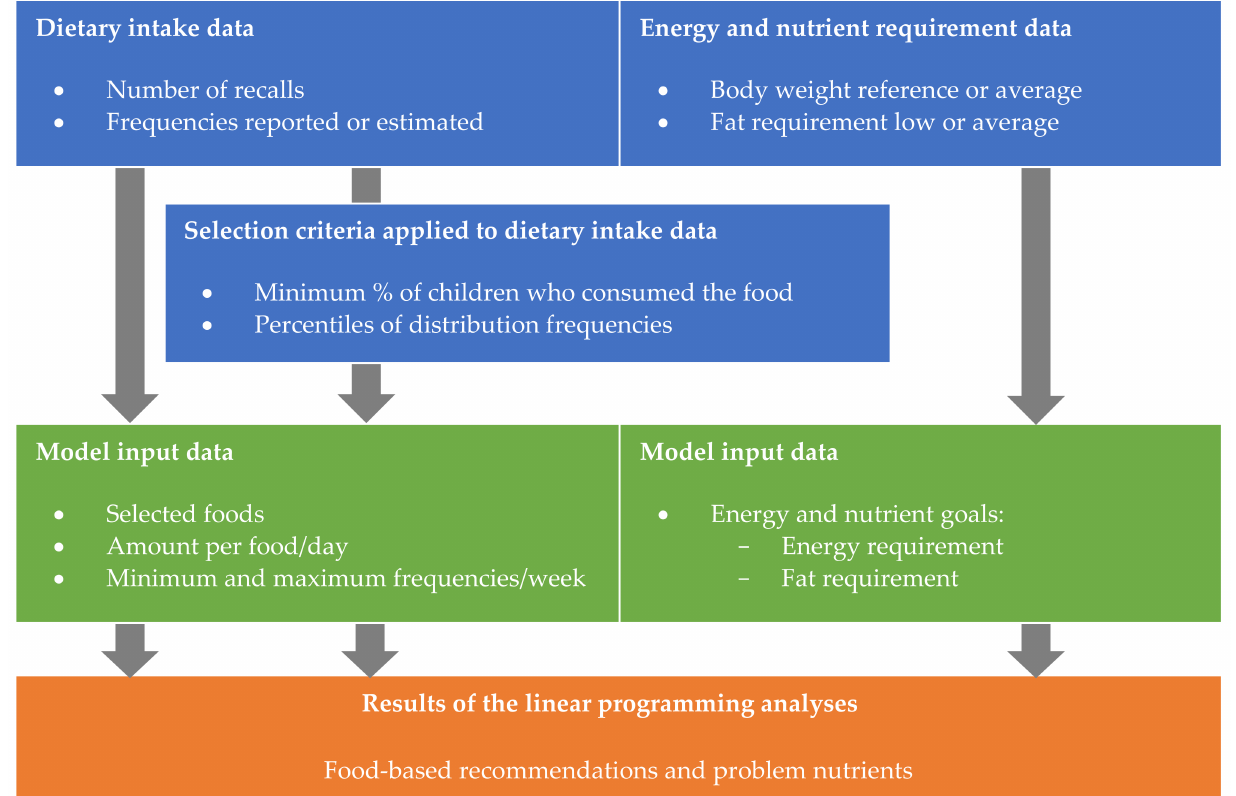
Figure 1. Illustration of the study design: to analyse the sensitivity of the developed FBR and type and number of problem nutrients to (1) quality of dietary intake data, (2) selection criteria applied to this data and (3) energy and nutrient requirement data using linear programming and 24 h dietary recalls of Kenyan children 4–6 years of